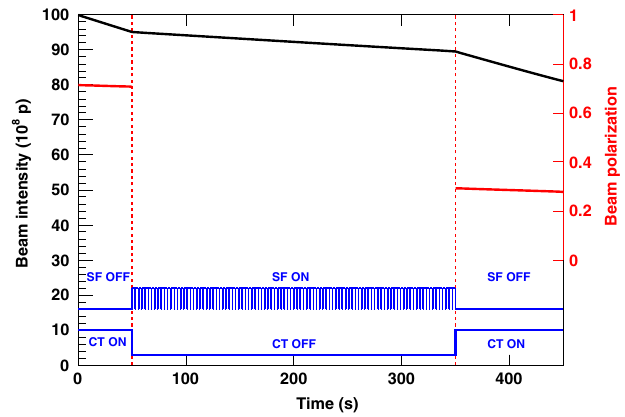
FIG. 26. Measurement cycle to determine the spin-flip (SF) efficiency. The beam polarization (red) is measured before ( P ¼ 99 spin flips. While these spin-flips are and after ( P ) n f flip being executed, the deuterium cluster target (CT) of the ANKE polarimeter is switched